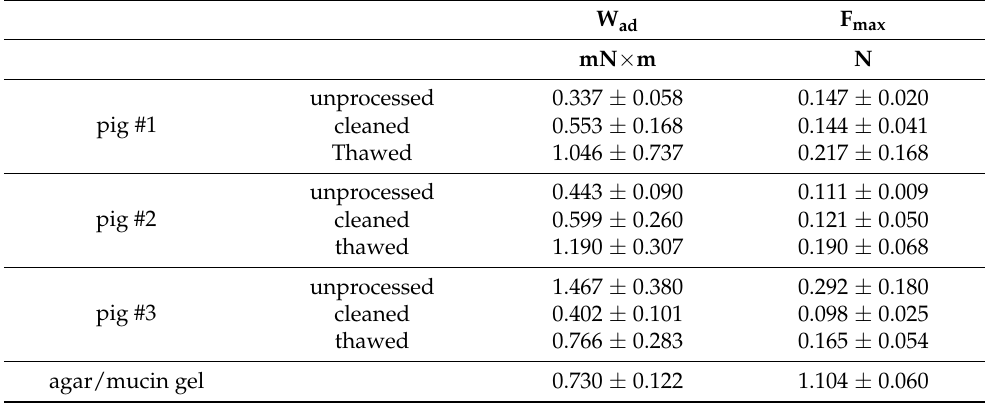
Table 2. Overview of the results (mean ± SD) of the mucoadhesion in vitro and ex vivo tests at the test parameters Fcontact = 0.35 N; tcontact = 180 s and withdrawal = 1.0